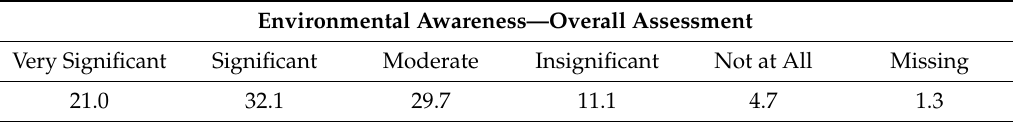
Table 13. Environmental awareness. Overall assessment.